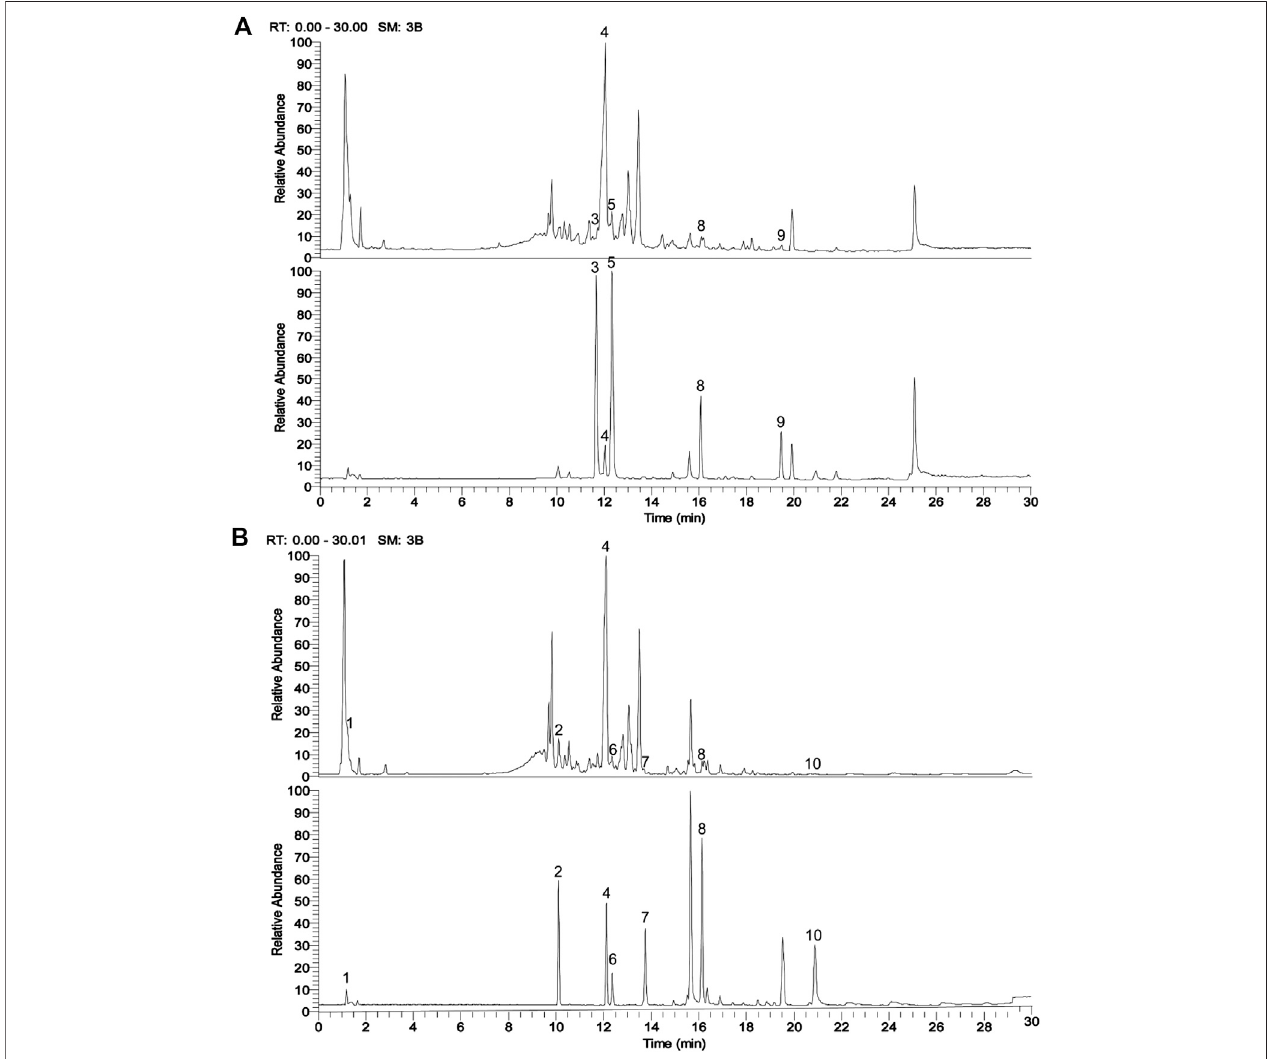
FIGURE 1 | UPLC chromatograms analysis of ASDZL with the representative active ingredients. (A) The total ion chromatogram (TIC) in positive ion mode (above, ASDZL; below, standards); (B) The TIC in negative ion mode (above, ASDZL; below, standards).